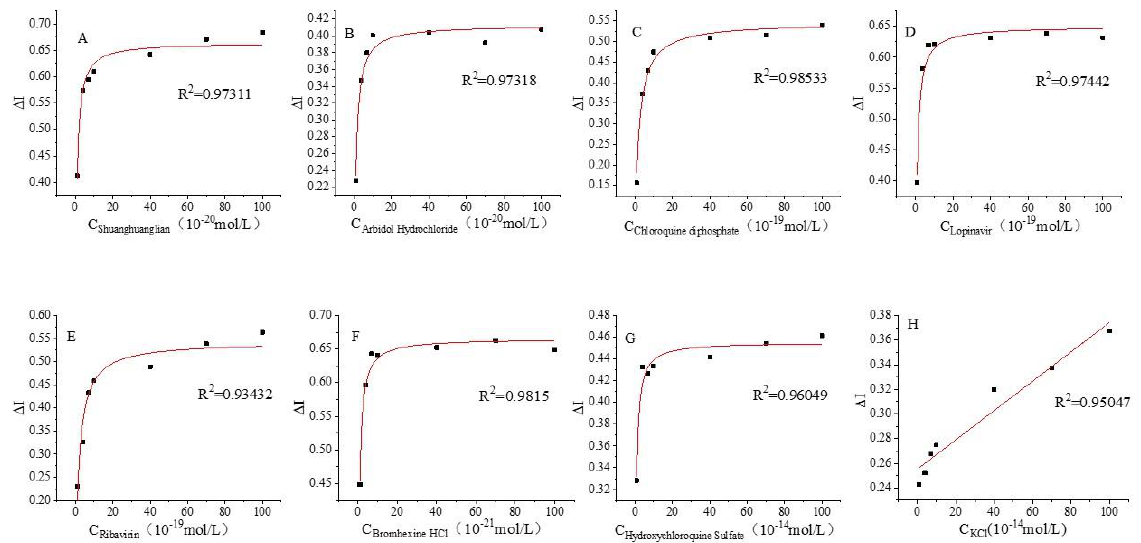
Figure 6. Fitted response curves: ( A ) Shuanghuanglian oral liquid 10 − 20 – 10 − 18 mol/L; ( B ) abridol 10 − 20 – 10 − 18 mol/L; ( C ) chloroquine diphosphate 10 − 19 – 10 − 17 mol/L; ( D ) lopinavir 10 − 19 – 10 − 17 mol/L; ( E ) rib- avirin 10 − 19 – 10 − 17 mol/L; ( F ) bromhexine 10 − 21 – 10 − 19 mol/L; and ( G ) hydroxychloroquine 10 − 14 – 10 − 12 mol/L (H) KCl 10 − 15 – 10 − 13 mol/L as control.